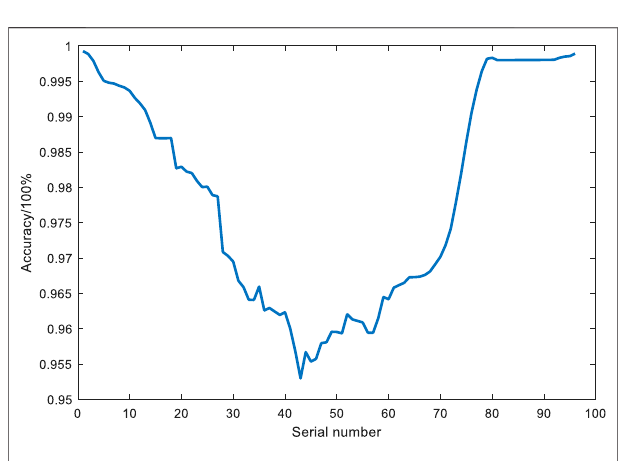
FIGURE 9 | Prediction accuracy at individually sampled points for June 21, the day with the highest daily average prediction accuracy.